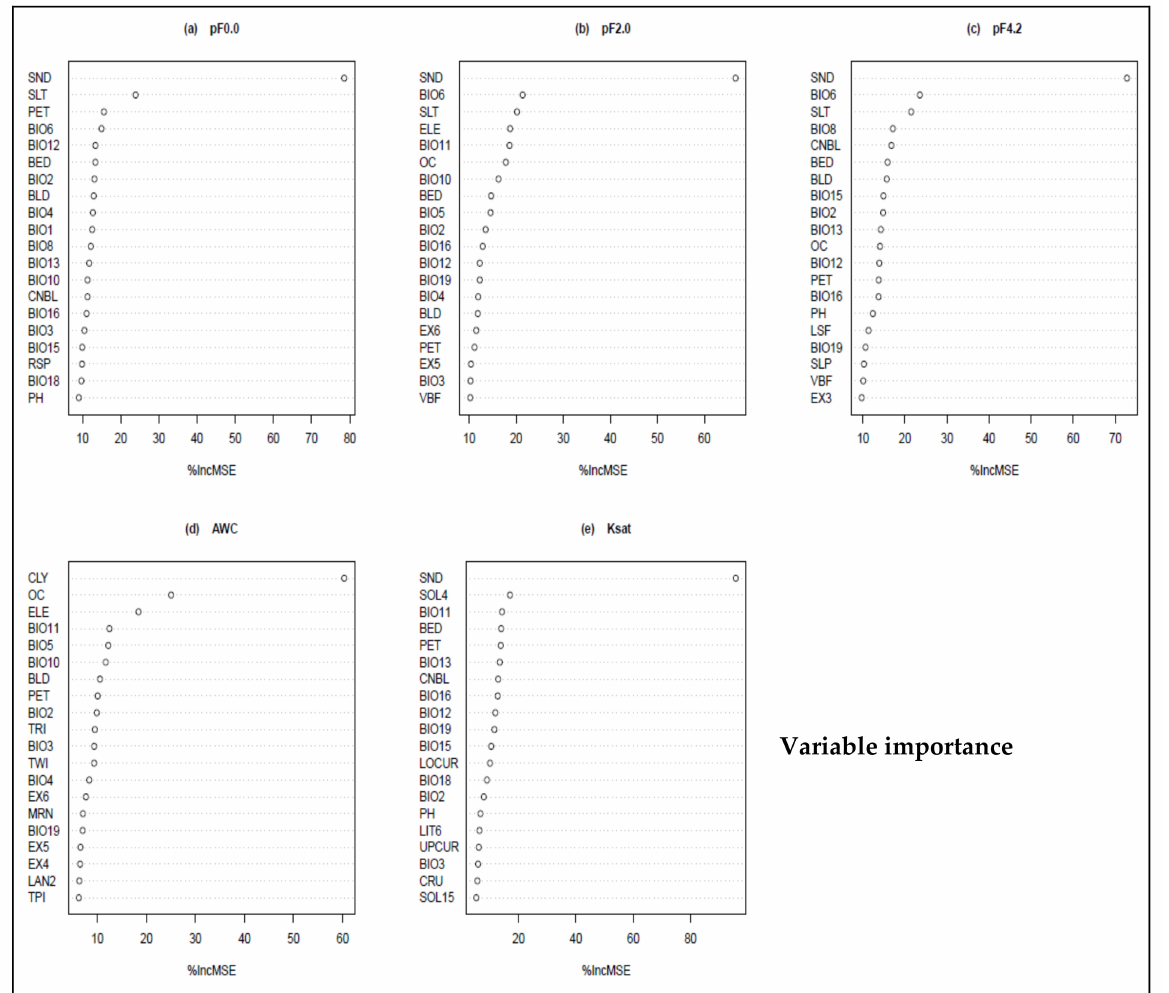
Figure 4. The 20 most important covariates for each of the 5 response variable expressed in terms of %IncMSE, as derived from a random forest model. Abbreviation of the covariates are given in Table 1. Panel ( a ) shows the covariates for response variable pF0.0, panel ( b ) for pF2.0, panel ( c ) for pF4.2, panel ( d ) for AWC and panel ( e ) for